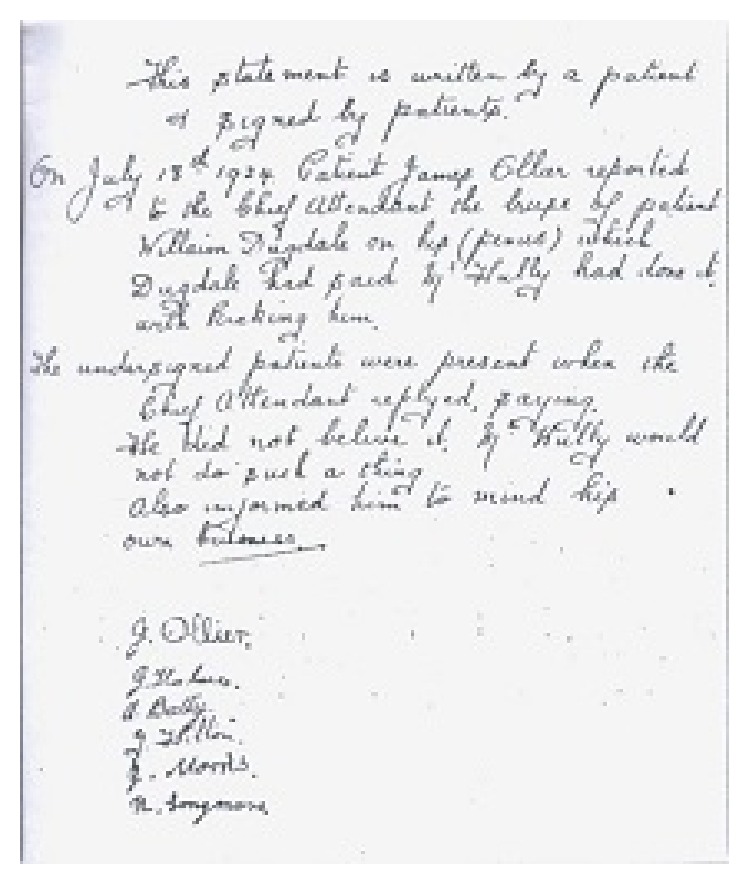
Watermark image.